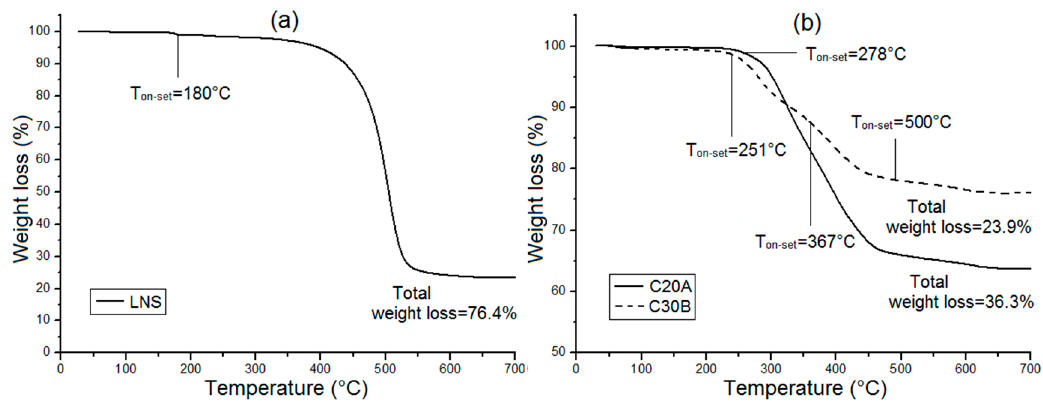
Figure 2. Thermogravimetric analysis (TGA) curves of the nanoparticles: ( a ) LSN; and ( b ) C20A and C30B.